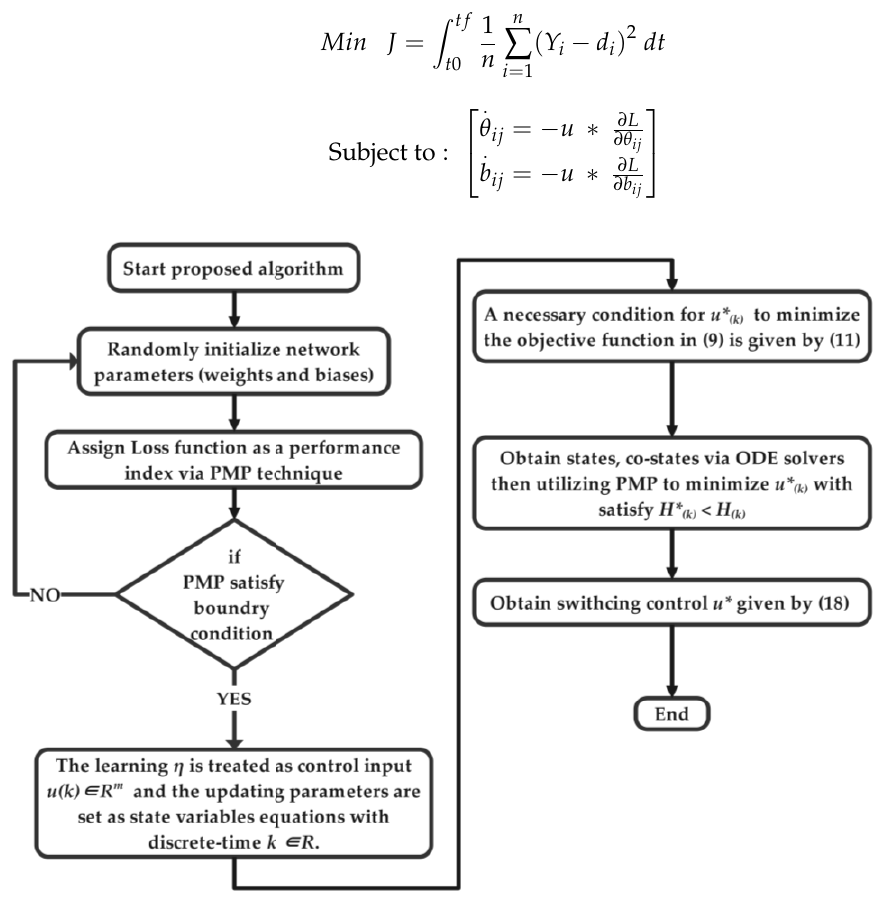
Figure 2. Flowchart of the proposed algorithm.